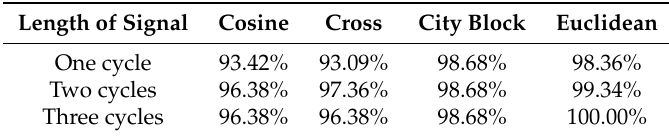
Table 3. Identification rates with the four different pattern matching methods using finger ECG data for 20 subjects.